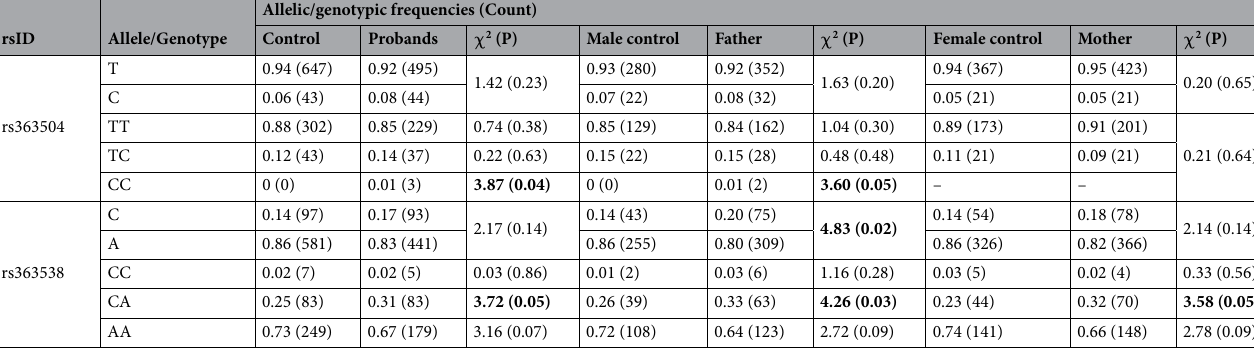
Table 1. Allelic and genotypic frequencies of GRIK1 variants in the studied population. N.B: Statistically significant differences are presented in